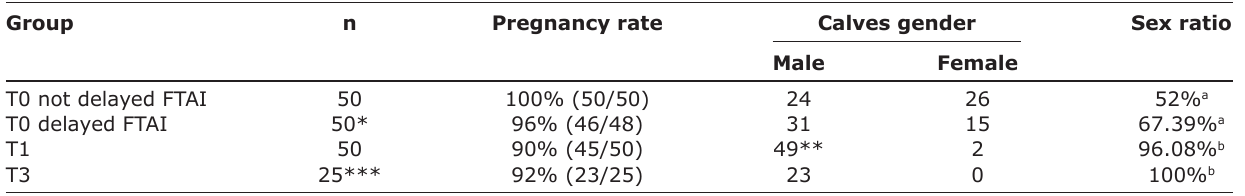
Table‑4: The pregnancy and sex ratio of the offspring.